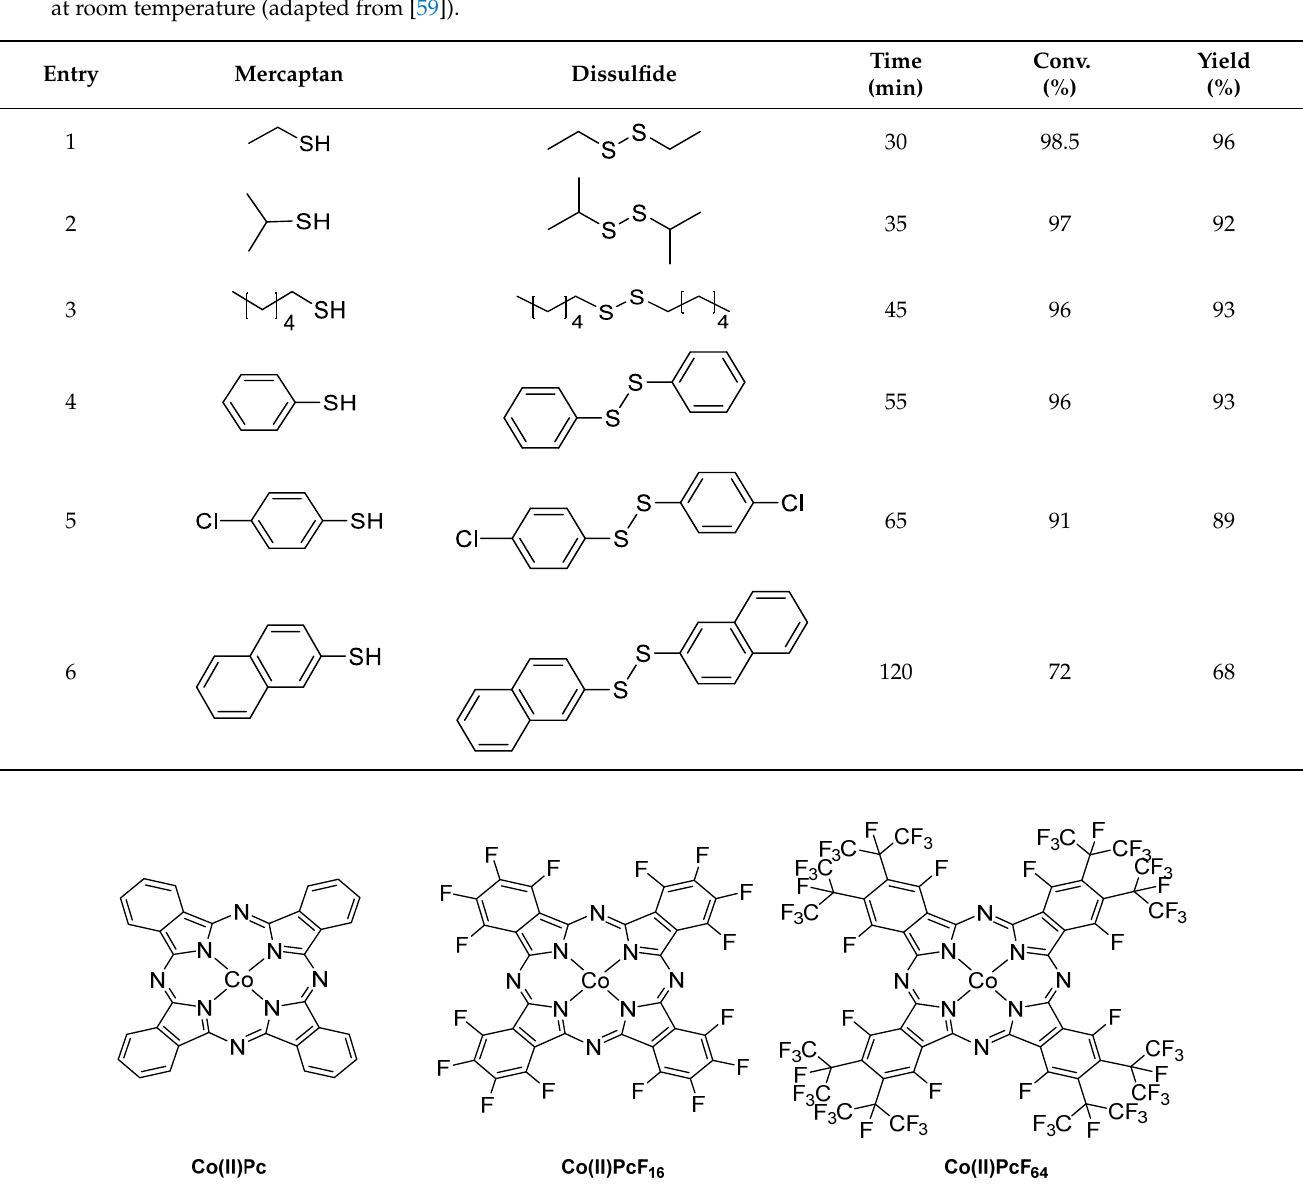
Figure 11. Structures of cobalt(II) phthalocyanine and its fluorinated derivatives used by Reid and Barat [60].